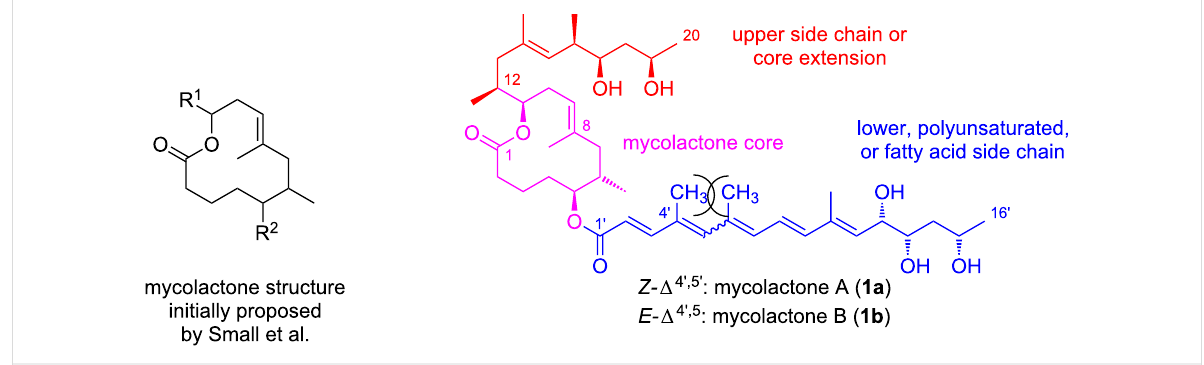
Figure 1: Initial proposal for the core macrolactone structure (left) and the established complete structure of mycolactones A ( 1a ) and B ( 1b ) (right).